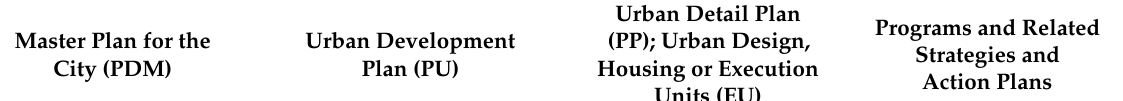
Table 1. Urban Planning and Design in Alc â ntara—a genealogy. Sources: own production Cf. References